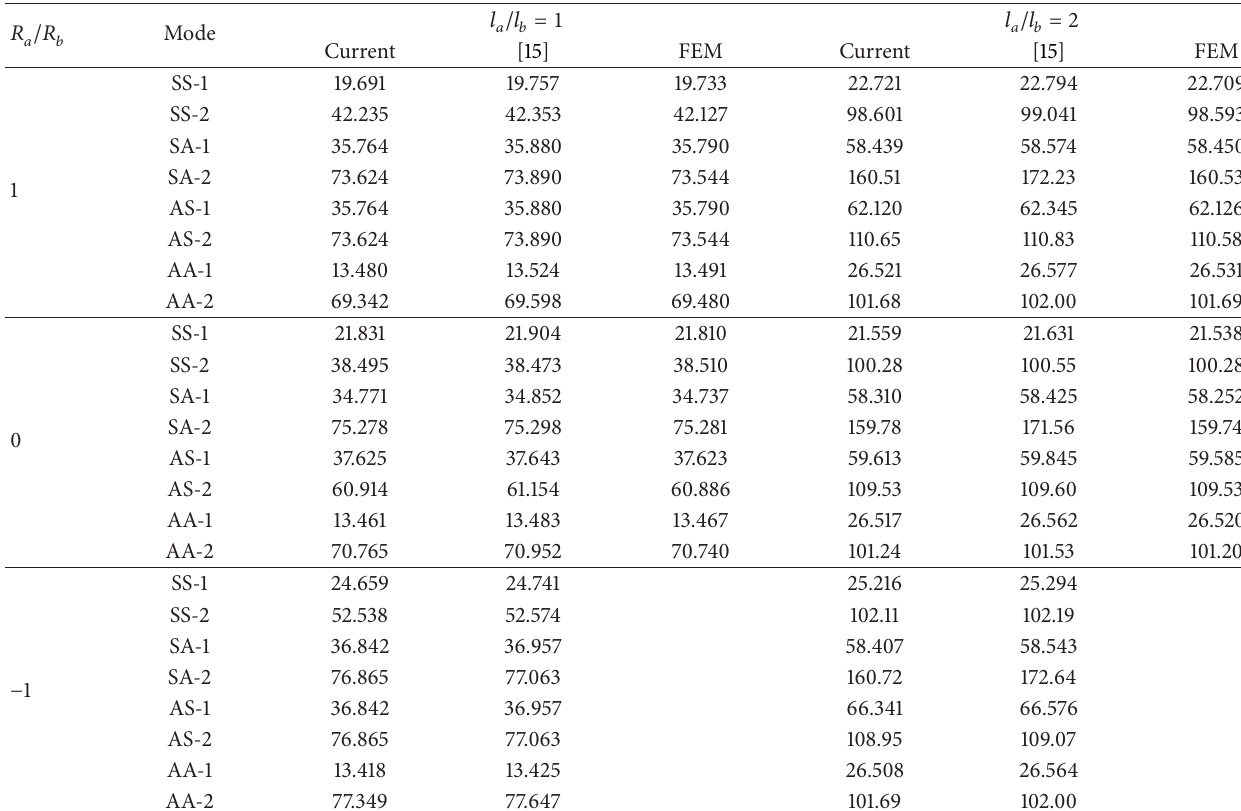
Table 2: Frequency parameters of completely free shallow shells having square and rectangular planform ( 𝑙 𝑎 / 𝑅 𝑎 = 0.2 , 𝑙 𝑎 / ℎ = 100 , and 𝜇 = 0.3